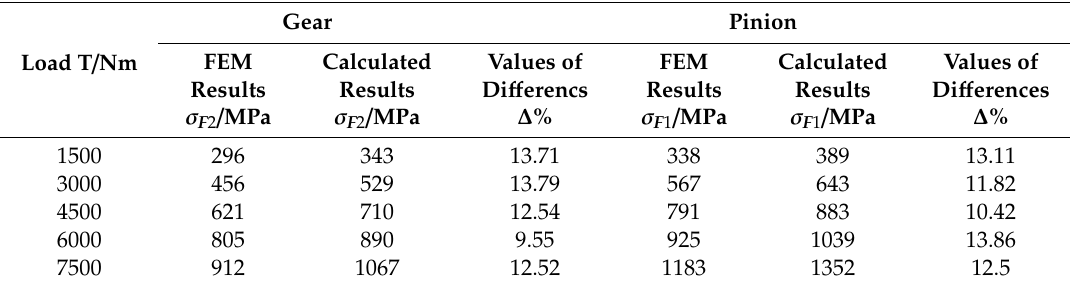
Table 4. Results comparison of FEM and empirical formula of bending